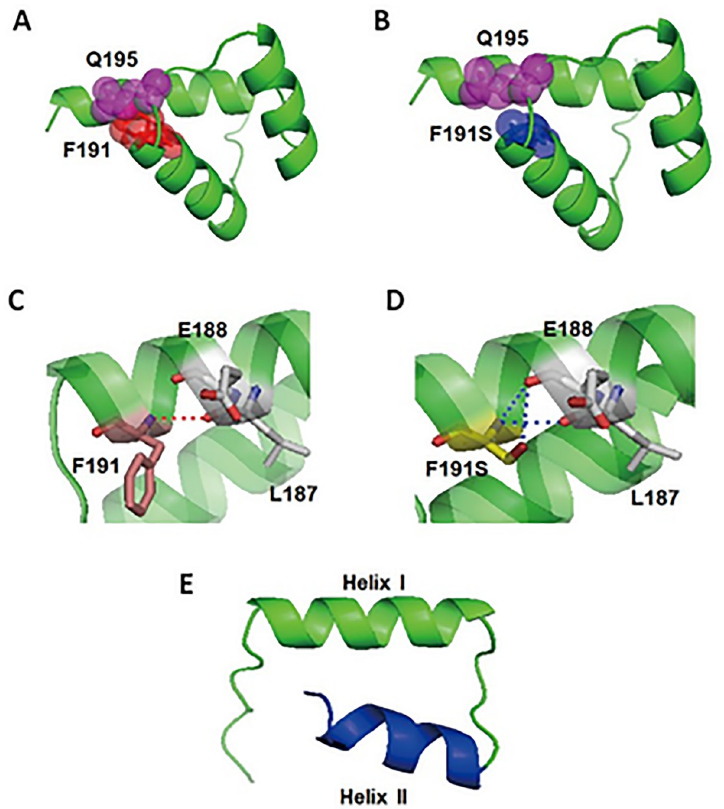
Fig 3. Structural modeling of the wide-type and the mutated homeodomain of MSX1 protein. (A, B) Structural modeling of the wide-type and the p. Phe191Ser mutated homeodomain of MSX1 protein show that the mutation is located at the end of the helix I. (A) In the wild-type MSX1 protein, the phenyl ring of the p. Phe191 is large and overlapped with p. Gln195. (B) In the p. Phe191Ser-mutated MSX1 protein, the phenyl ring disappears, a large gap between p.191Ser and p.Gln195 arise. (C) Phe191 forms a hydrogen bond with Leu187. (D) The Phe191Ser mutation creates another two new hydrogen bonds with Glu188. (E) Structural modeling of the c.590_594 dup TGTCC mutated homeodomain of MSX1protein by Pymol. The mutant structural shows that helix I is conserved, but helixes II and III are disrupted.